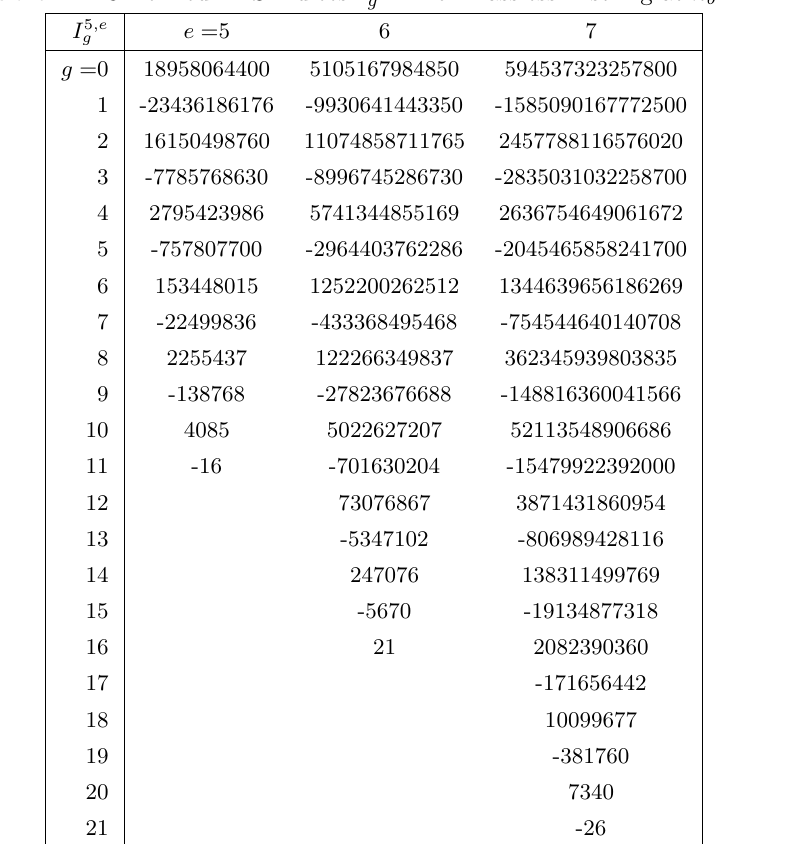
for massless E-string at n b = g